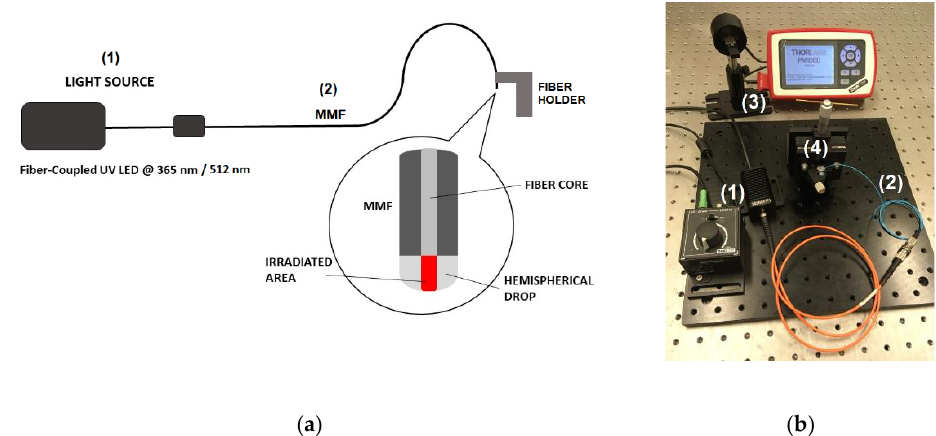
Figure 1. Sketch ( a ) and image ( b ) of the experimental set-up for the microtip manufacturing: (1) light source (UV LED-M365FP1 or VIS LED-M530F2 with LEDD1B driver, both ThorLabs , Newton, New Jersey, USA), (2) MMF 105, (3) power meter with sensor (S140C with PM100D console, both ThorLabs , Newton, New Jersey, USA), (4) fiber holder.